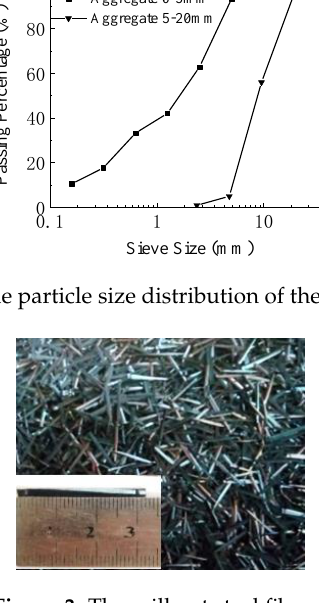
Figure 3. The mill-cut steel fibers. Figure 3. The mill - cut steel fibers. Figure 3. The mill - cut steel fibers. Table 1. The physical and mechanical properties of the fine and coarse aggregates. Figure 3. The mill - cut steel fibers.